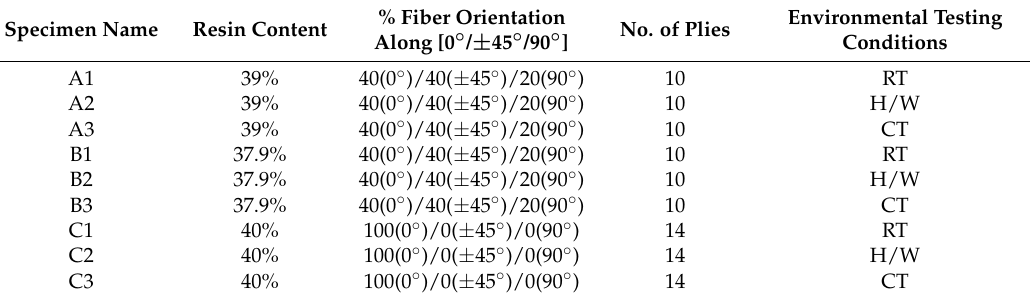
Table 1. Denomination of materials and testing